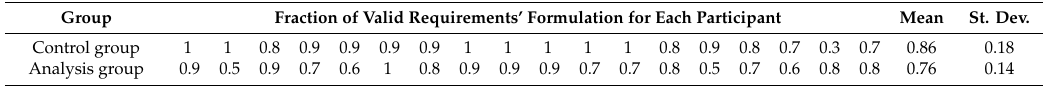
Table 8. Fraction of valid requirements for each subject, after the skimming process aimed at eliminating non-valid requirements.